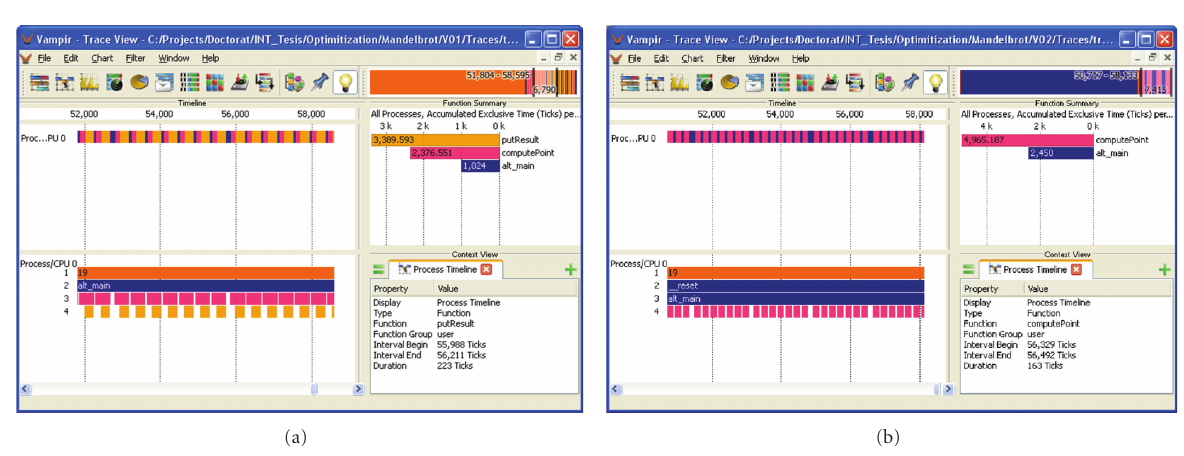
Figure 13: Performance optimization of Mandelbrot application using transparent tracing. (a) Trace visualization of the the original version. (b) Trace visualization of the optimized version.